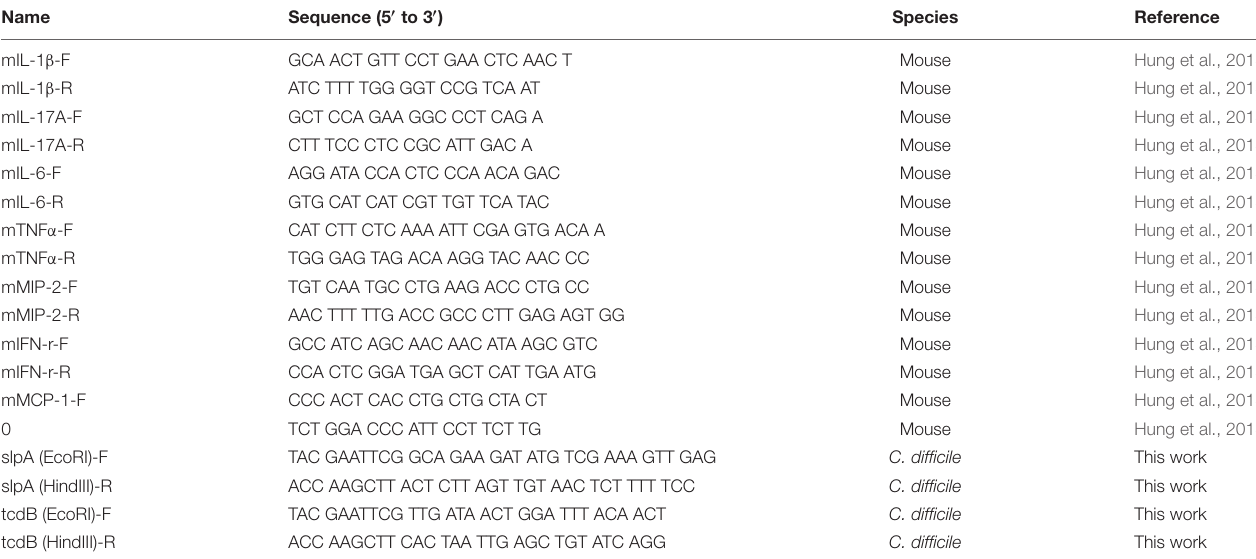
TABLE 1 | Sequences of oligonucleotide primers used in this